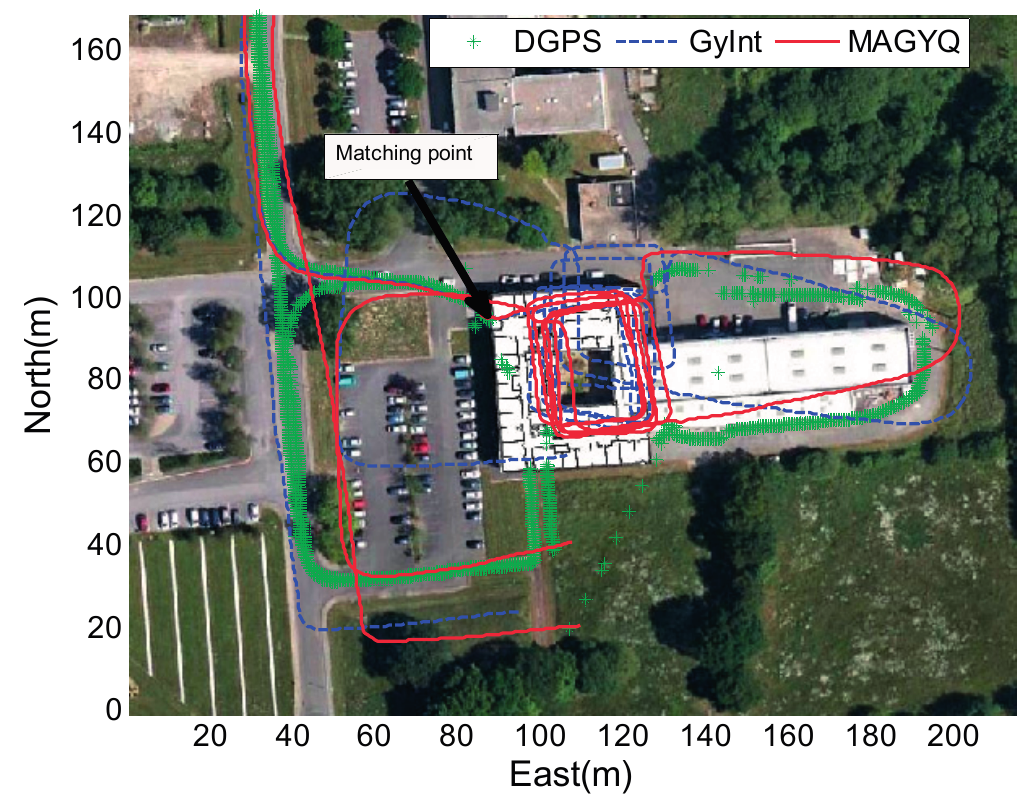
Figure 13. Walking paths of